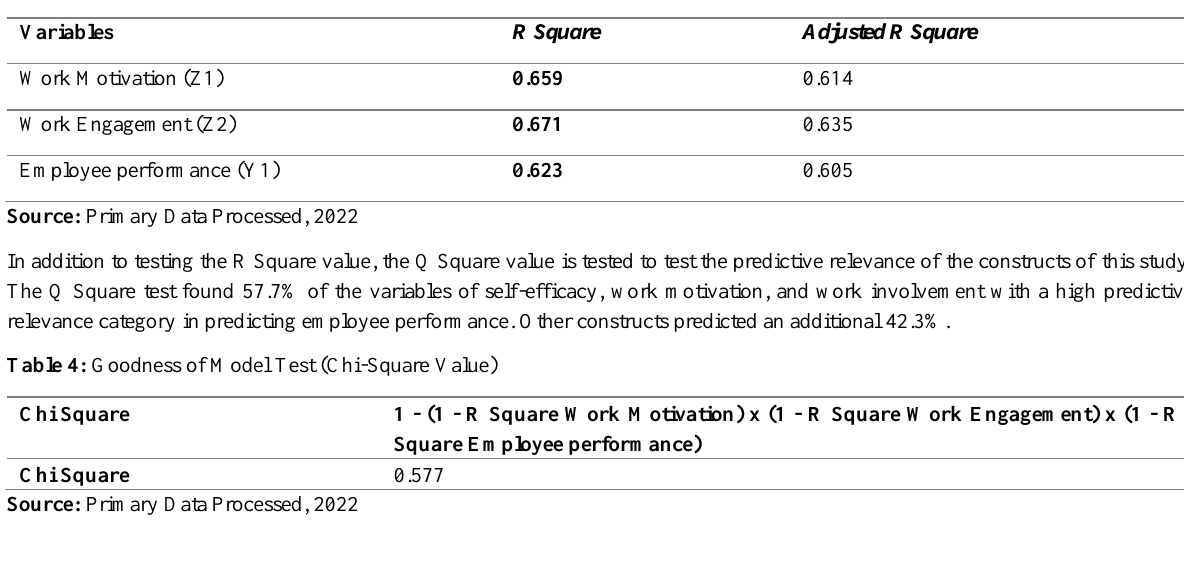
Table 3: Goodness of Model Test (R Square Value)